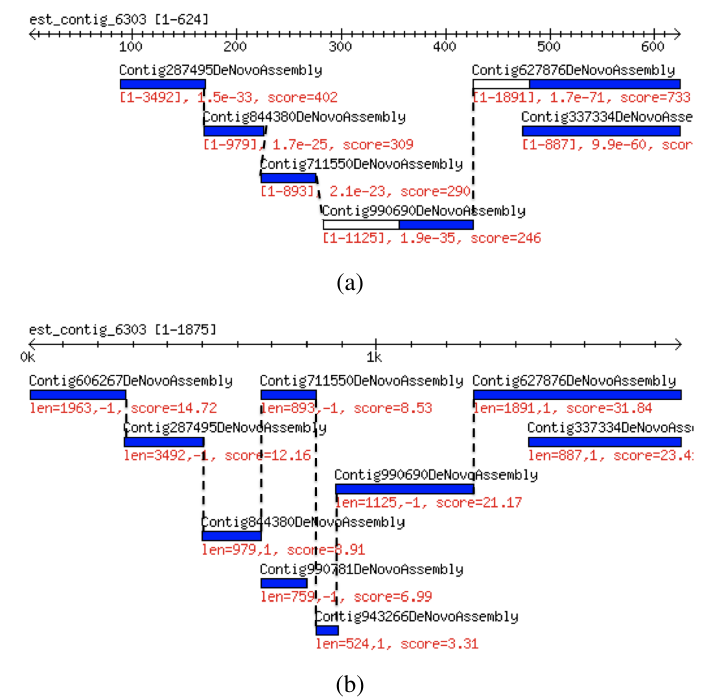
Figure 5: Using RNA and protein contigs to scaffold genomic contigs. Genomic contigs shown in blue are aligned to protein contig 6303 (a) and RNA contig 6303 (b) depicted by the first line in each panel. Hits in the same region are ordered by the mapped scores, with the best matches at the top. Dotted lines indicate that the contigs can be joined with unknown gap